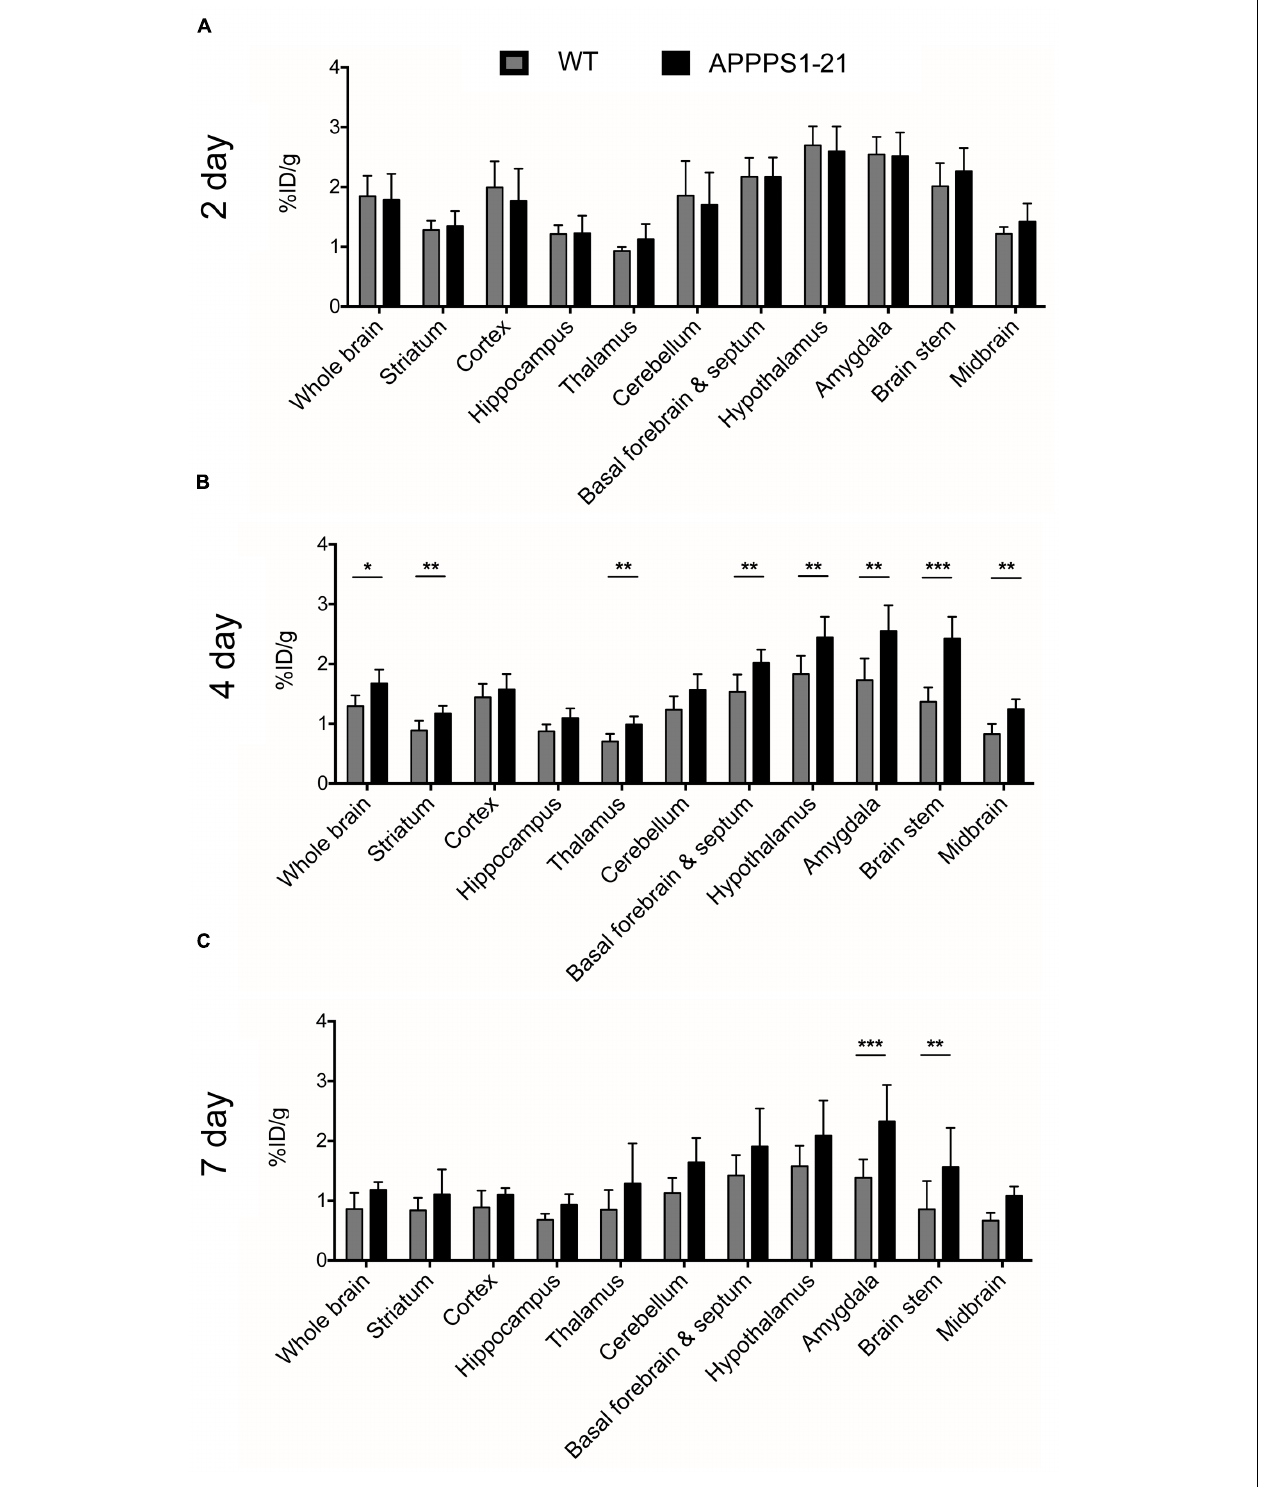
FIGURE 1 | µ PET imaging demonstrates increased brain uptake of [ 89 Zr]-Df-Bz-JRF/A β N/25 in APPPS1–21 mice in comparison to WT. Mice were injected with 133 µ g of [ 89 Zr]-Df-Bz-JRF/A β N/25 and brain uptake was measured by µ PET scanning and quantified as the %ID/g. The graphs show the VOI analysis of [ 89 Zr]-Df-Bz-JRF/A β N/25 retention in WT and APPPS1–21 mice at (A) 2 days pi, (B) 4 days pi, and (C) 7 days pi. Significant genotype differences in retention were observed at 4 and 7 days pi. Data is presented as mean + SD. Student’s t -test, ∗∗∗ p < 0.001, ∗∗ p < 0.01, ∗ p < 0.05.